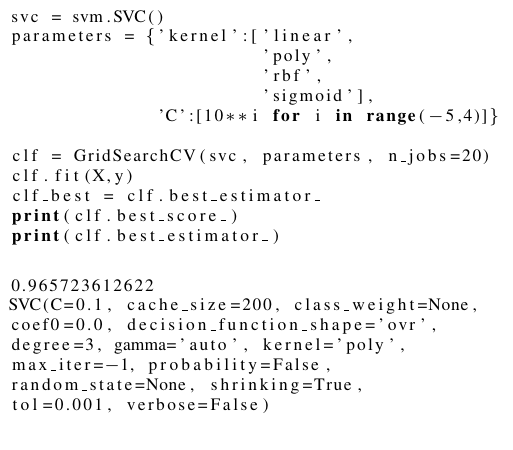
Figure 20. Here we train the machine learning algorithm and print out the result. caption=Results of the training. Here we see that best estimator predicts correctly 96.6% of the time.